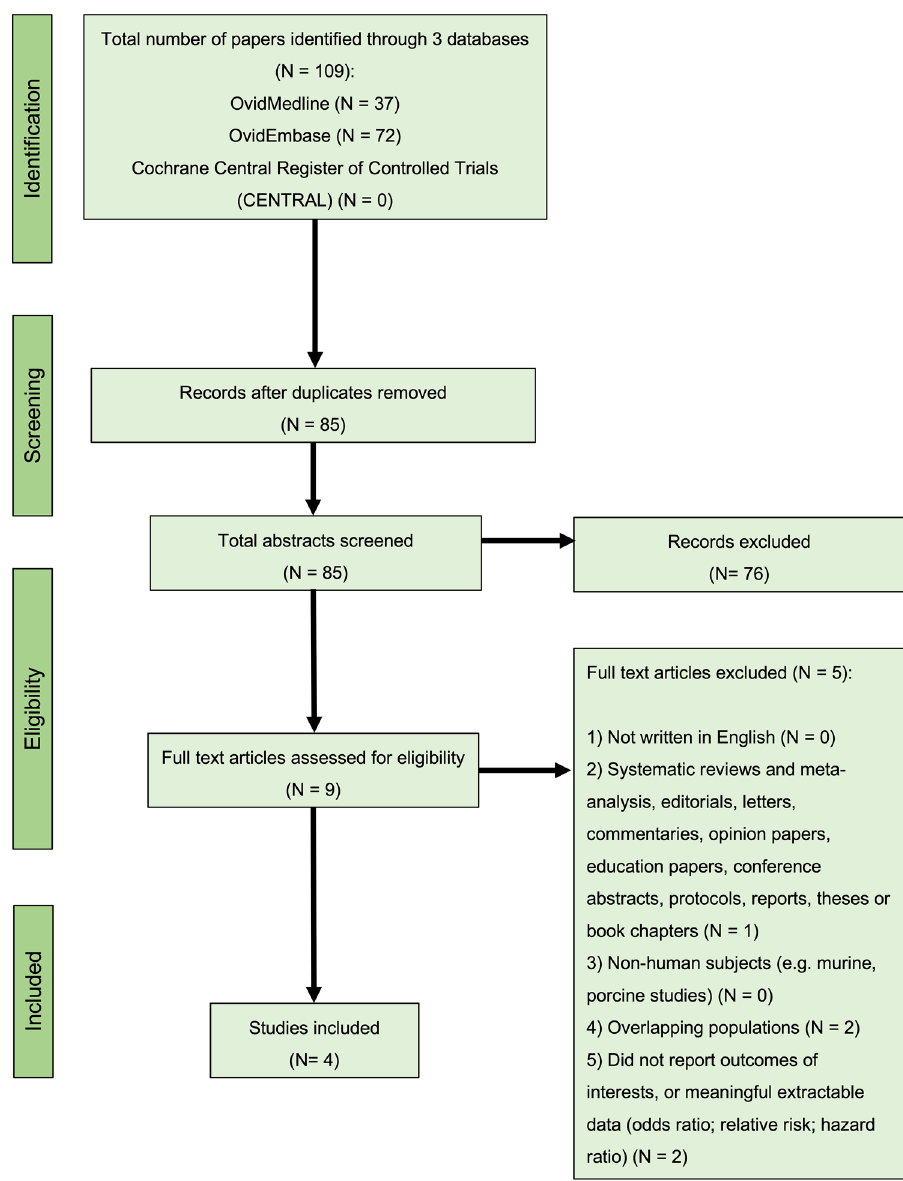
Figure 1. PRISMA flow diagram for studies included and excluded from the systematic review and meta-